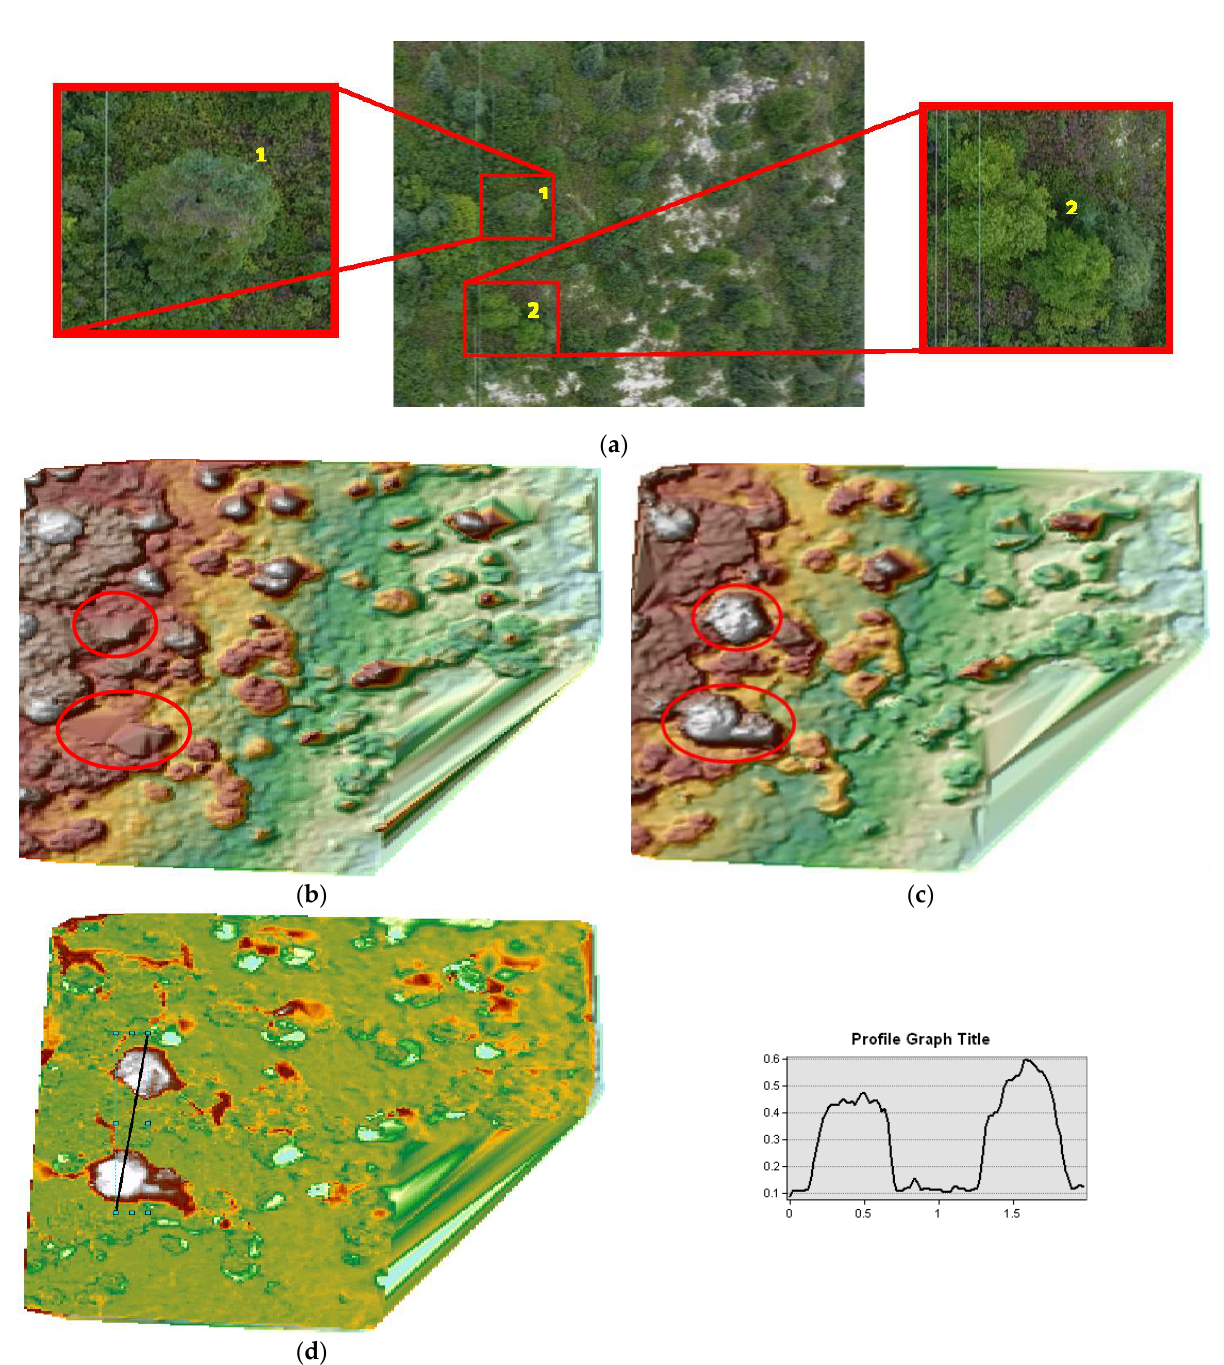
Figure 11. The image captured at the desired area ( a ), the generated DSM by Agisoft ( b ), as well as the proposed method, ( c ) are also shown from the first dataset. The subtraction of two DSMs, in addition to the profile graph, is also demonstrated ( d ).